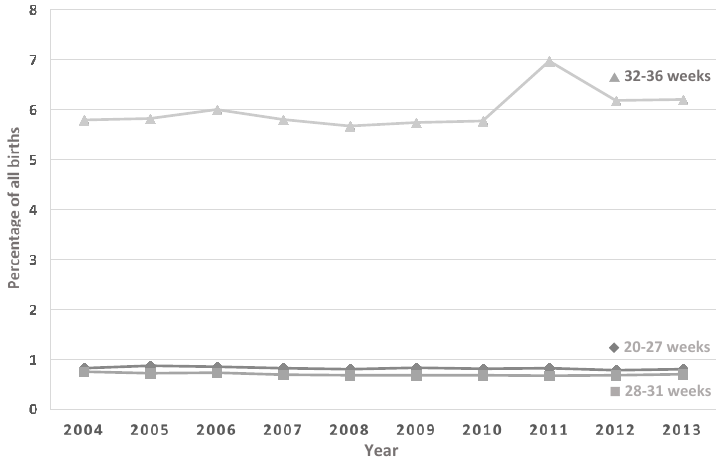
Figure 1. Preterm births as a percentage of all births in Australia, 2004 to 2013. There have been slight but significant increases in the percentage of preterm births in the 20–27 week group (R = 0.68; aR 2 = 0.47; p = 0.03) and 28–31 week group (R = 0.73; aR 2 = 0.48; p = 0.02) but no change in the 32–36 week group (R = 0.52; aR 2 = 0.18; p = 0.12). From AIHW Australia’s Mothers and Babies